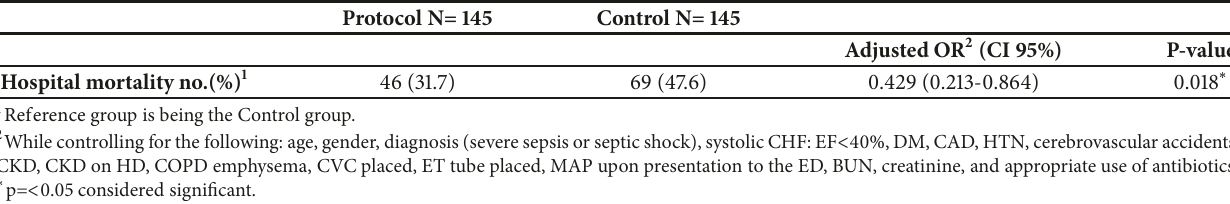
Table 5: Multiple logistic regression for hospital